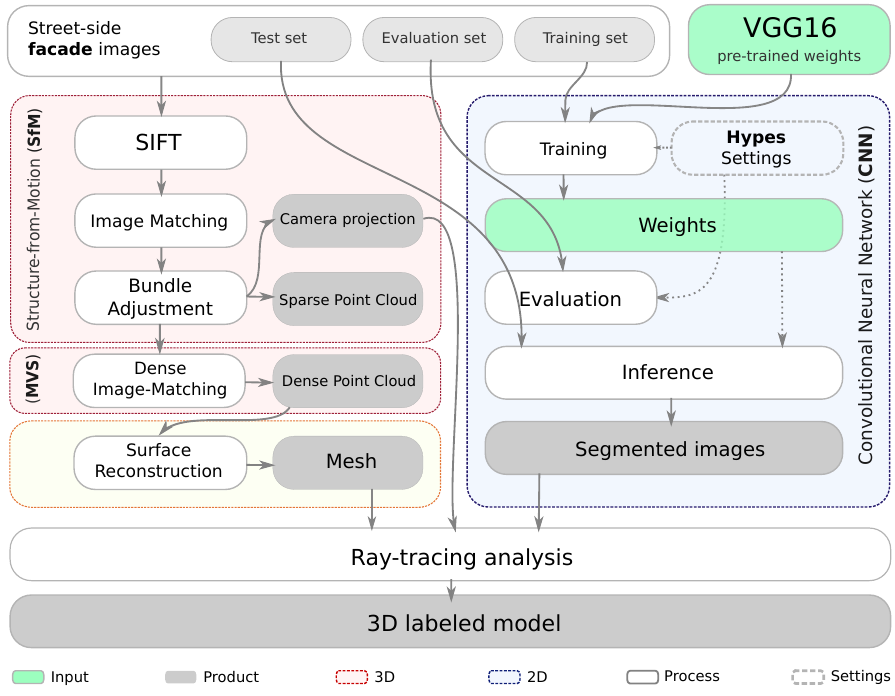
Figure 2. 3D façade model: façade feature extraction and reconstruction